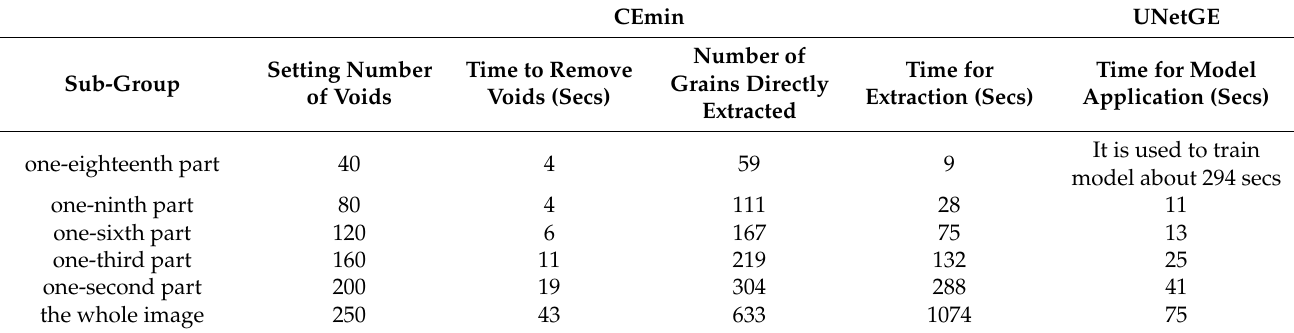
Table 4. The time to extract grains using CEmin and UNetGE, respectively.